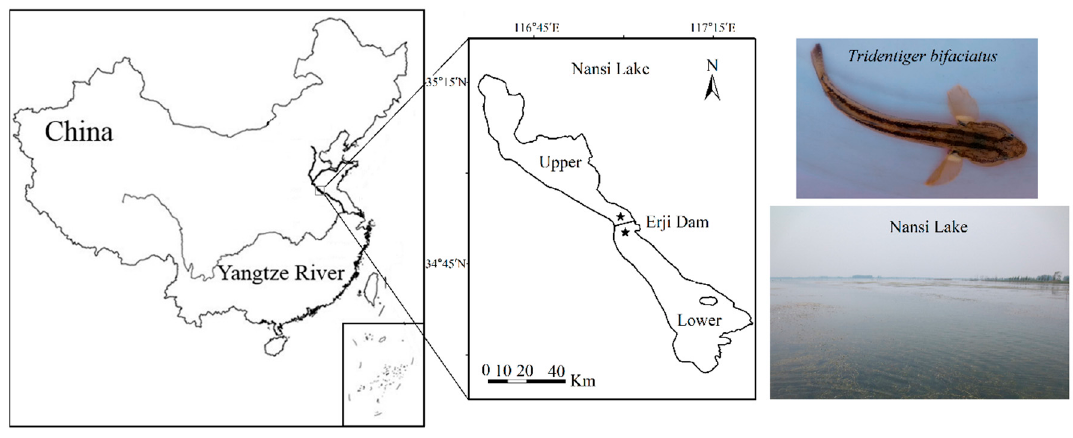
Figure 1. Nansi Lake, a storage lake of the East Route of the South-to-North Water Transfer Project, China, showing sampling locations for the Shimofuri goby ( Tridentiger bifasciatus ).